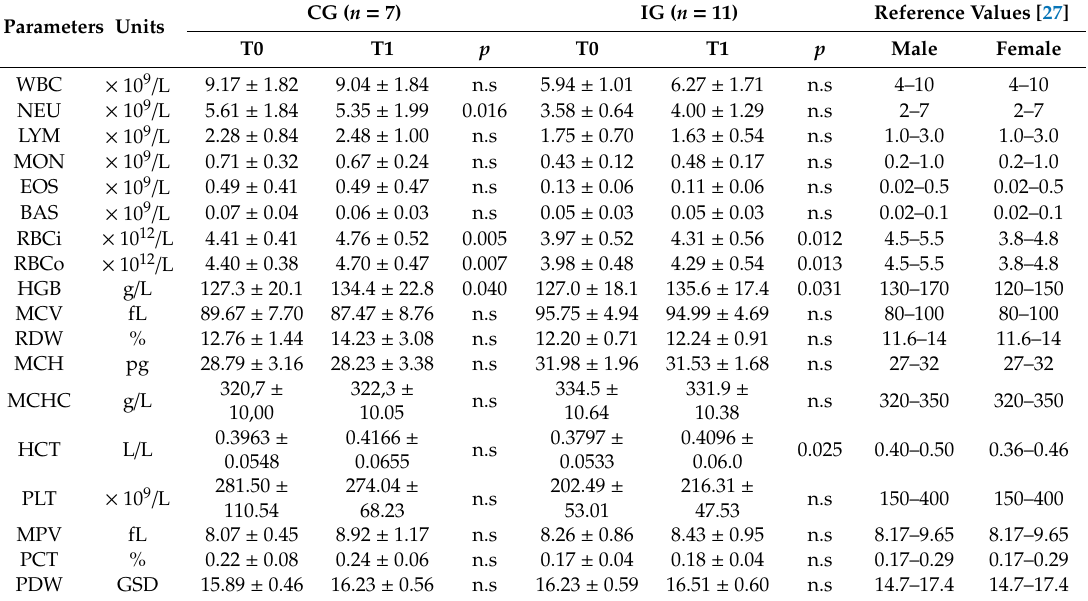
Table 2. Hematological parameters measured in CG and IG at moments T0 and T1, presented in medium values ± standard deviation and respective reference range values.